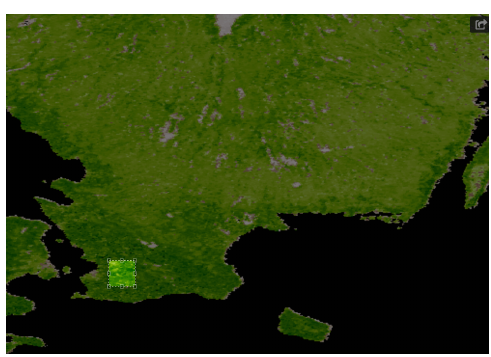
Figure 2. The square shows the area in Sweden from which we obtained land surface temperature in images of 28 × 28 pixels, with a resolution (per pixel) of 1 km.